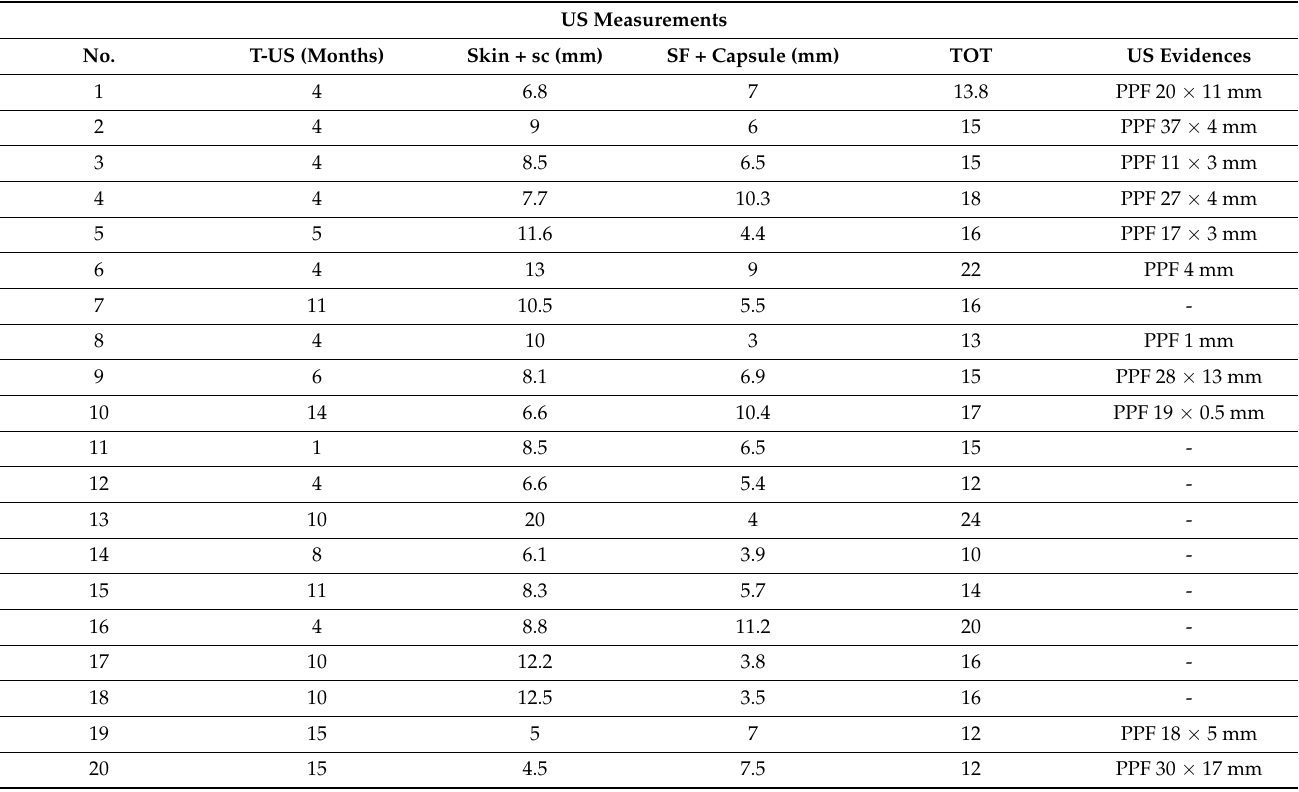
Table 2. US measurements, T-US: time from surgery to US examination, PPF: periprosthetic fluid, skin + sc: skin + subcutaneous thickness, SF: serratus fascia, TOT: Total thickness over the expander. US